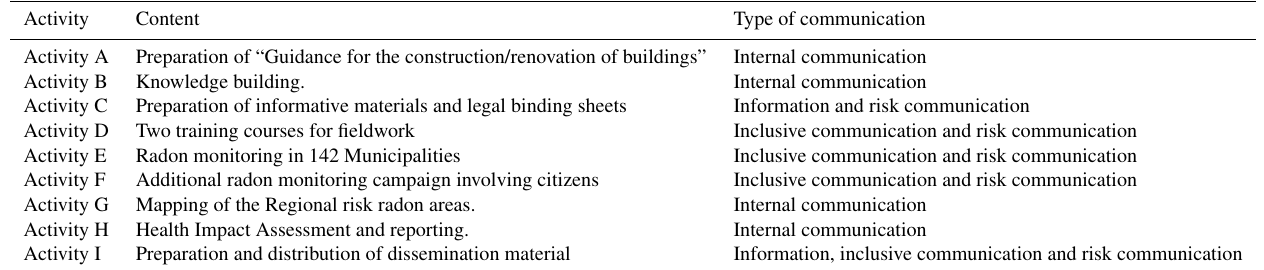
Table 1. Activities developed under the Sardinia Region indoor radon prevention programme and related communication.